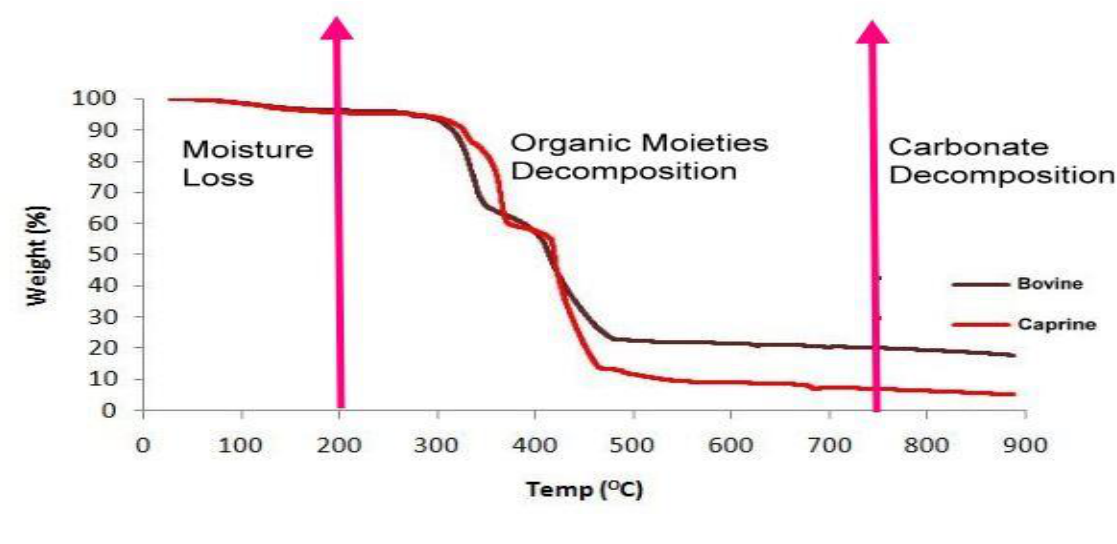
Fig. 2. TGA Results of raw bovine and caprine bone samples.